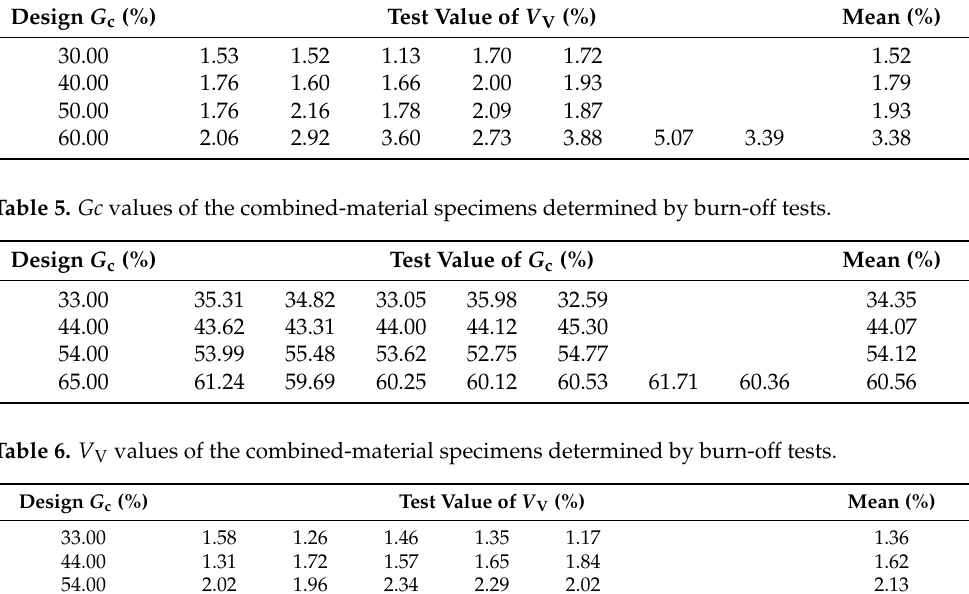
Table 4. V V values of the single-material specimens determined by burn-off tests. Design G c (%)